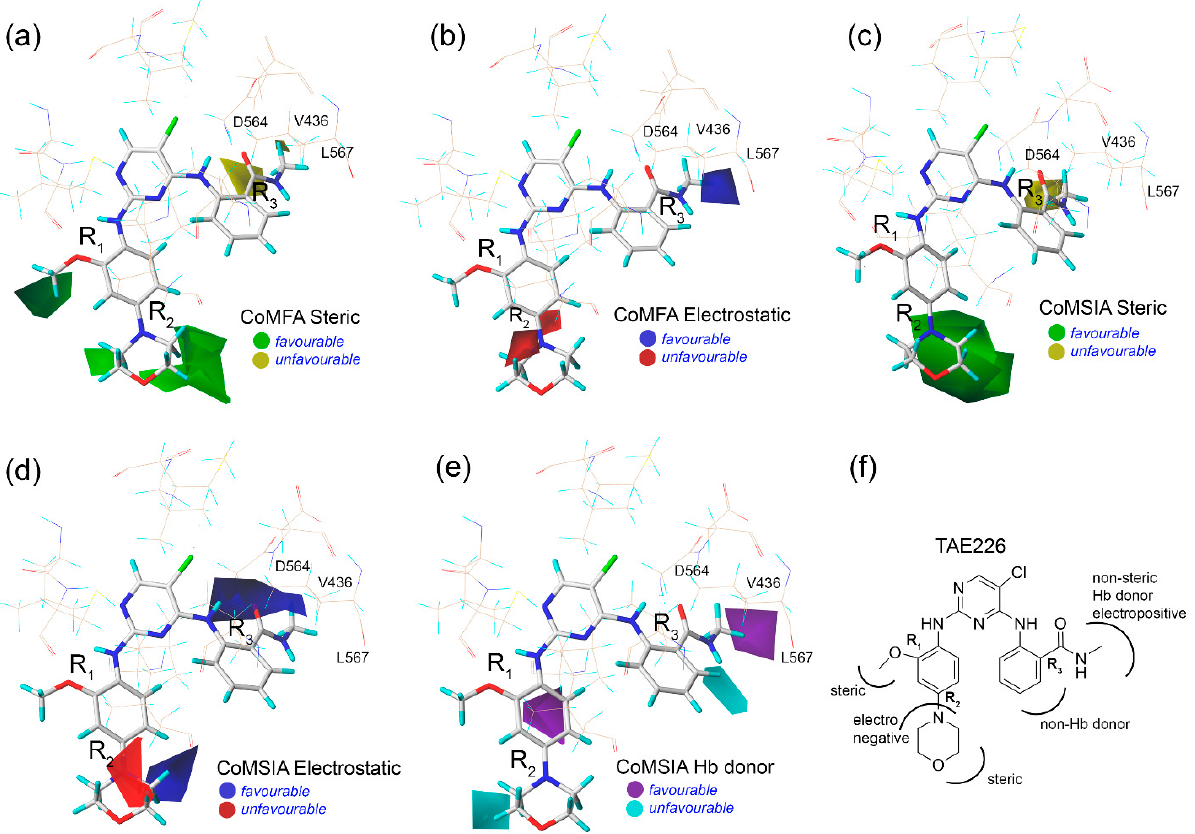
Figure 3. Contour map analysis and structure–activity relationship study from 3D-QSAR. ( a ) The steric contour map and ( b ) electrostatic contour map from CoMFA. ( c – e ) are steric, electrostatic, and H-bond (Hb) donor contour maps from CoMSIA. ( f ) Implementation of the SAR diagram from the CoMFA and CoMSIA analyses by taking TAE226 (C36) as a reference.